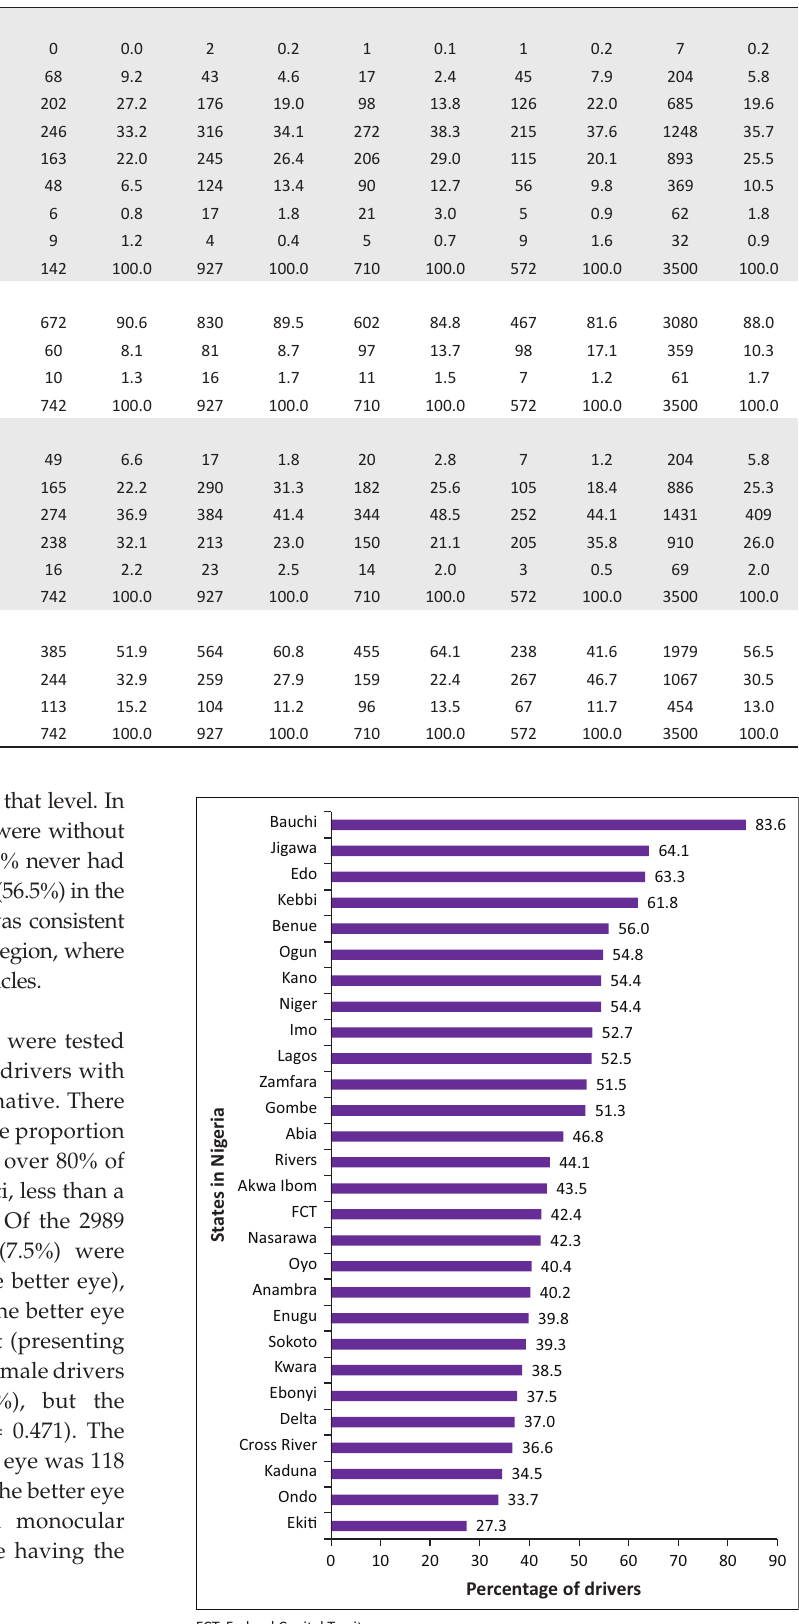
TABLE 1: Driver’s characteristics. Socio-demographic characteristics